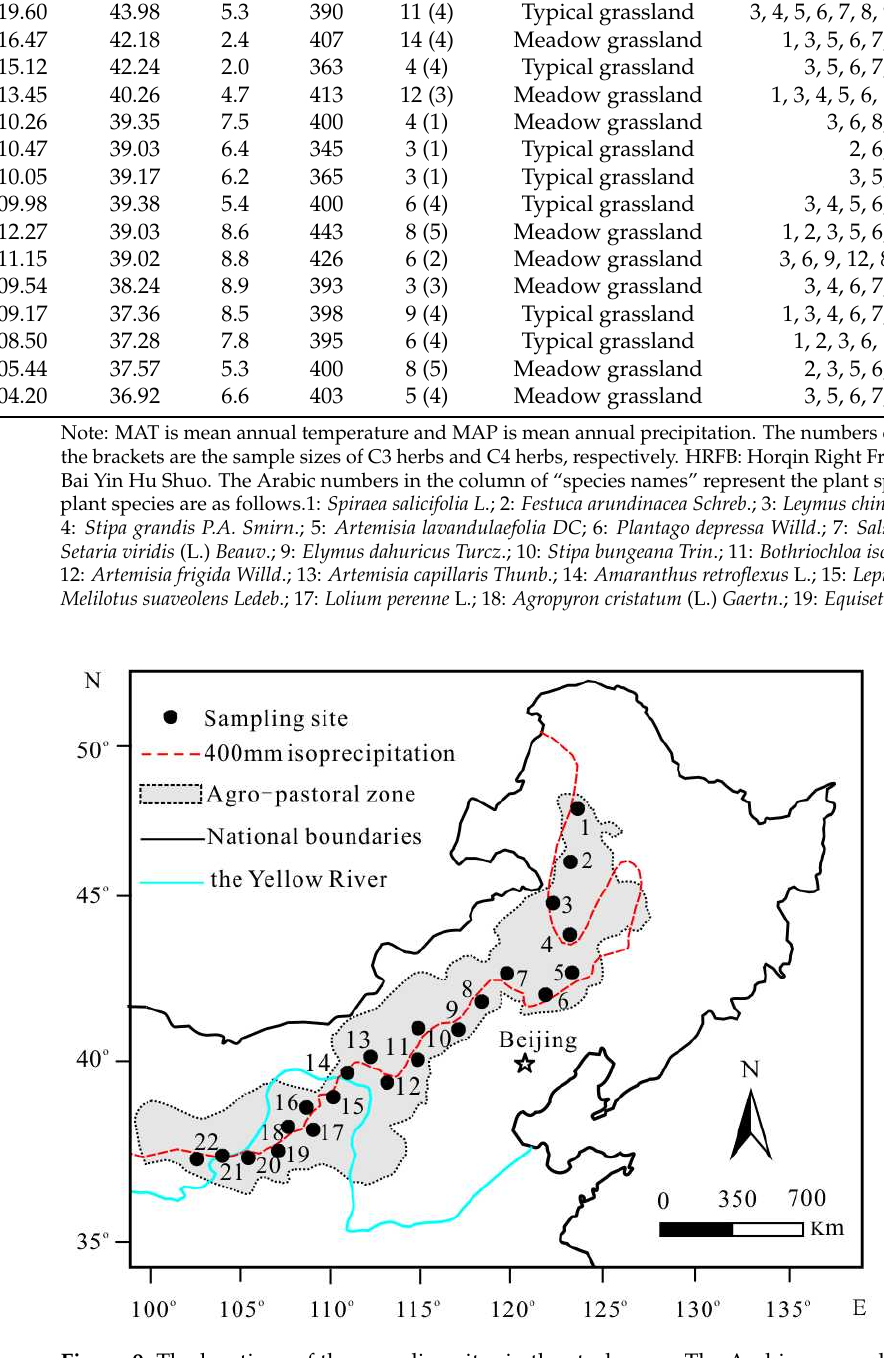
Figure 9. The locations of the sampling sites in the study area. The Arabic numerals in Figure 9 are the numbers of sampling sites, which correspond to the serial numbers in Table 3. Table 3. The information of the sampling sites and plant species collected at each site.